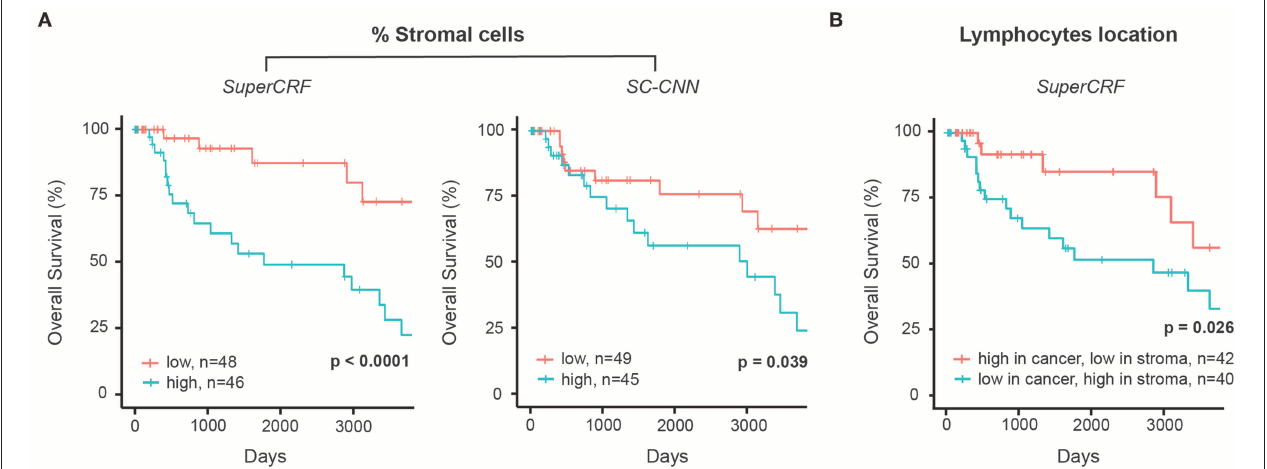
FIGURE 3 | Associations between survival outcomes and SuperCRF-define risk groups in the Cancer Genome Atlas (TCGA) cohorts of patients with melanoma. (A) Kaplan-Meier Survival curves for patients in the high-risk group (blue) and low risk group classified by stromal cells ratio derived from SuperCRF (left) and using only the SC-CNN classifier. Note the difference in the p-value using the two methods. (B) Kaplan-Meier Survival curves for patients in the high-risk group (blue) and low risk group classified by immune phenotype based on spatial distribution of lymphocytes in different tumor compartments derived from SuperCRF.